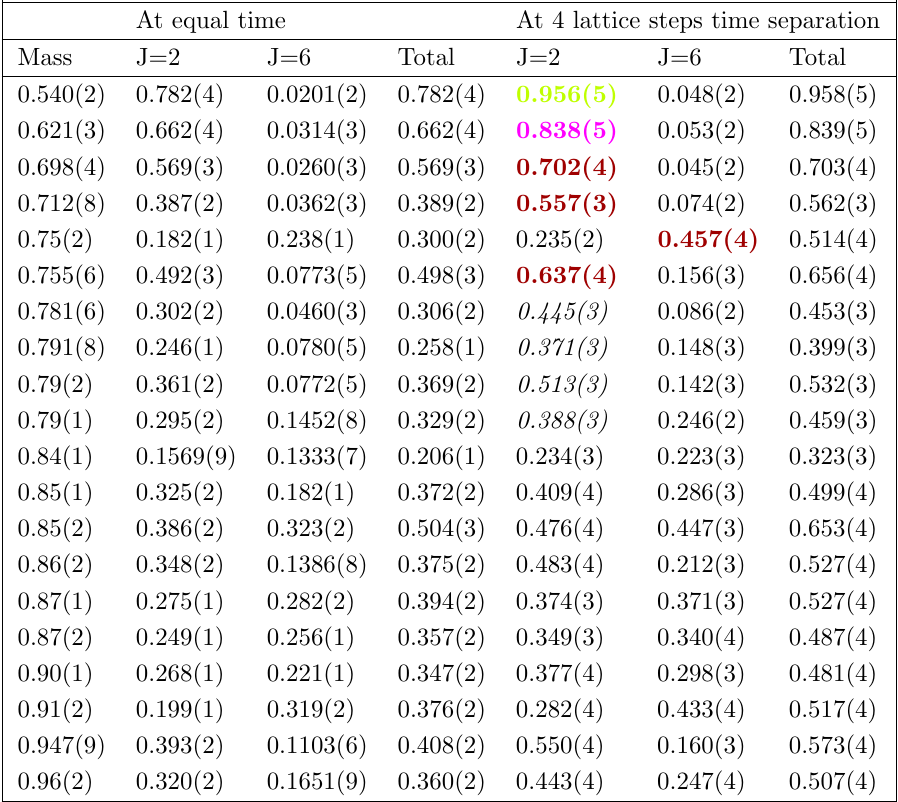
Table 18. Masses from glueballs in A 3 and A 4 representations with C = (cid:0) averaged over P , using conventional operators and overlaps with AR